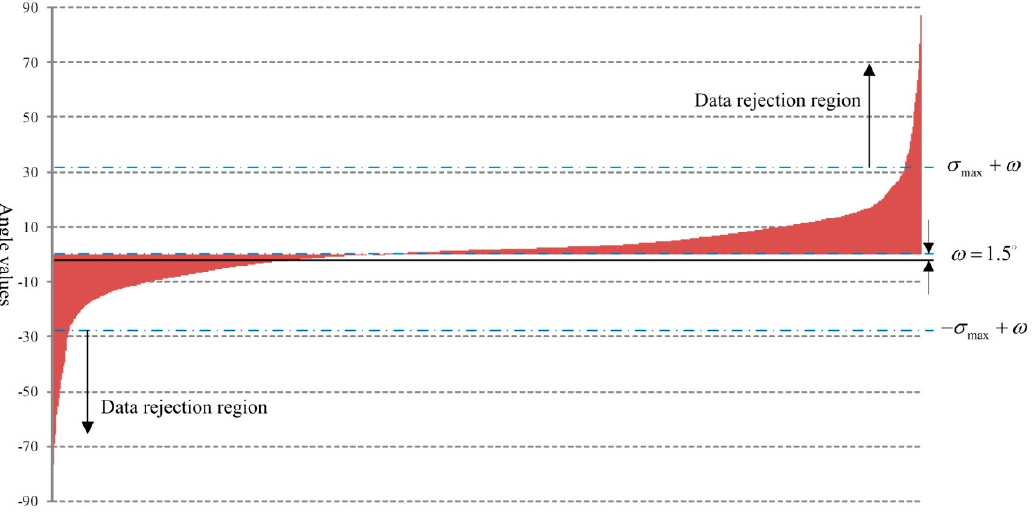
Figure 6. Angle distribution. Figure 6. Angle